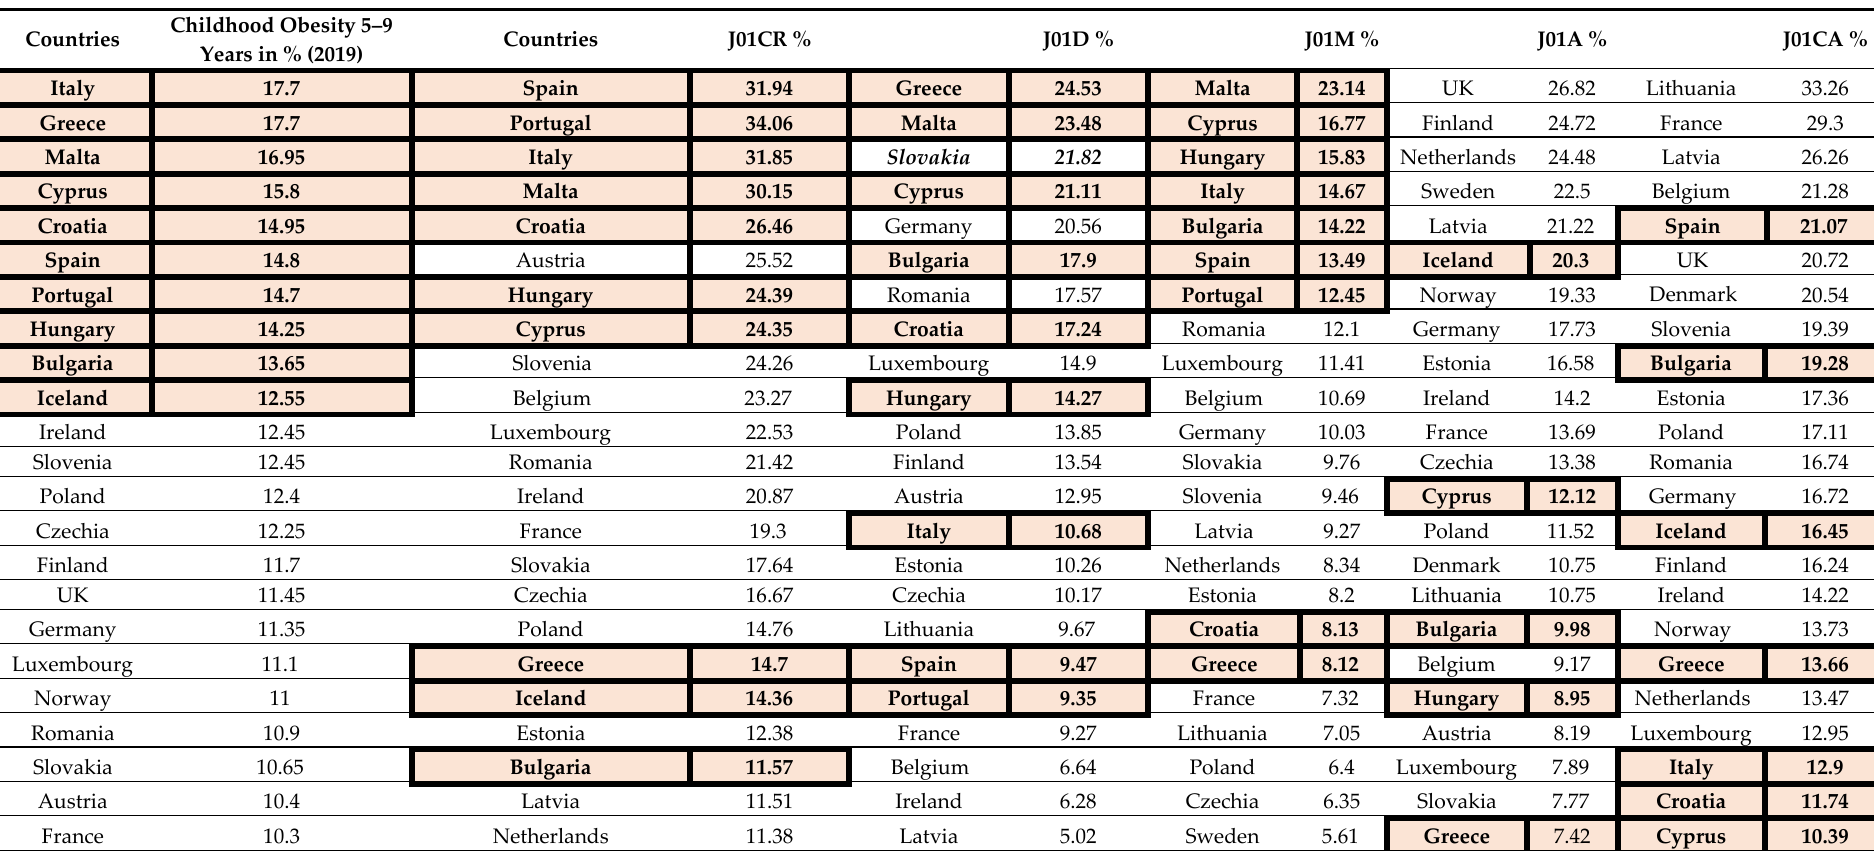
Table 3. The rank order of the prevalence of childhood obesity (first 10 positions, bold, framed) compared to the rank orders of the obesity “promoter” (J01CR, J01D, J01M) and “inhibitor” (J01A, J01CA) antibiotics.